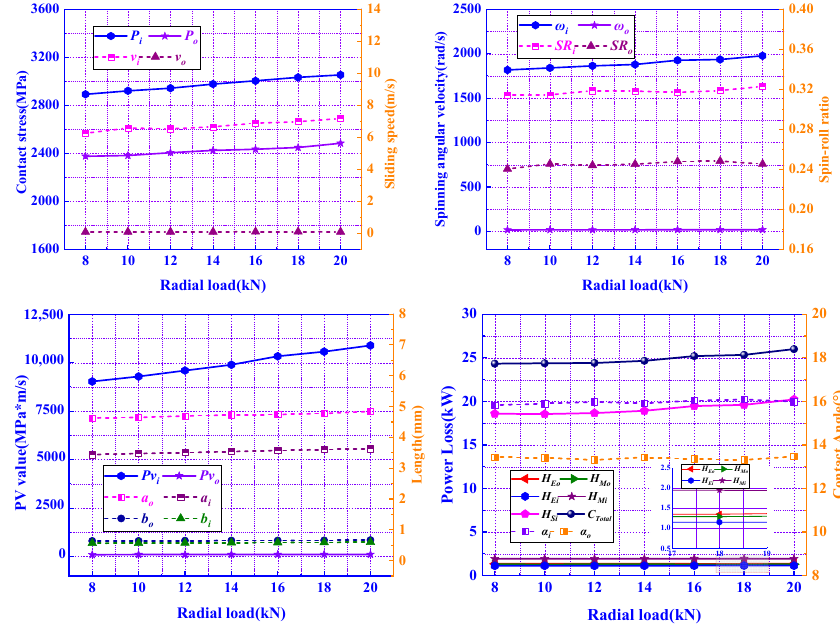
Figure 19. Influence of radial load F r on power loss.